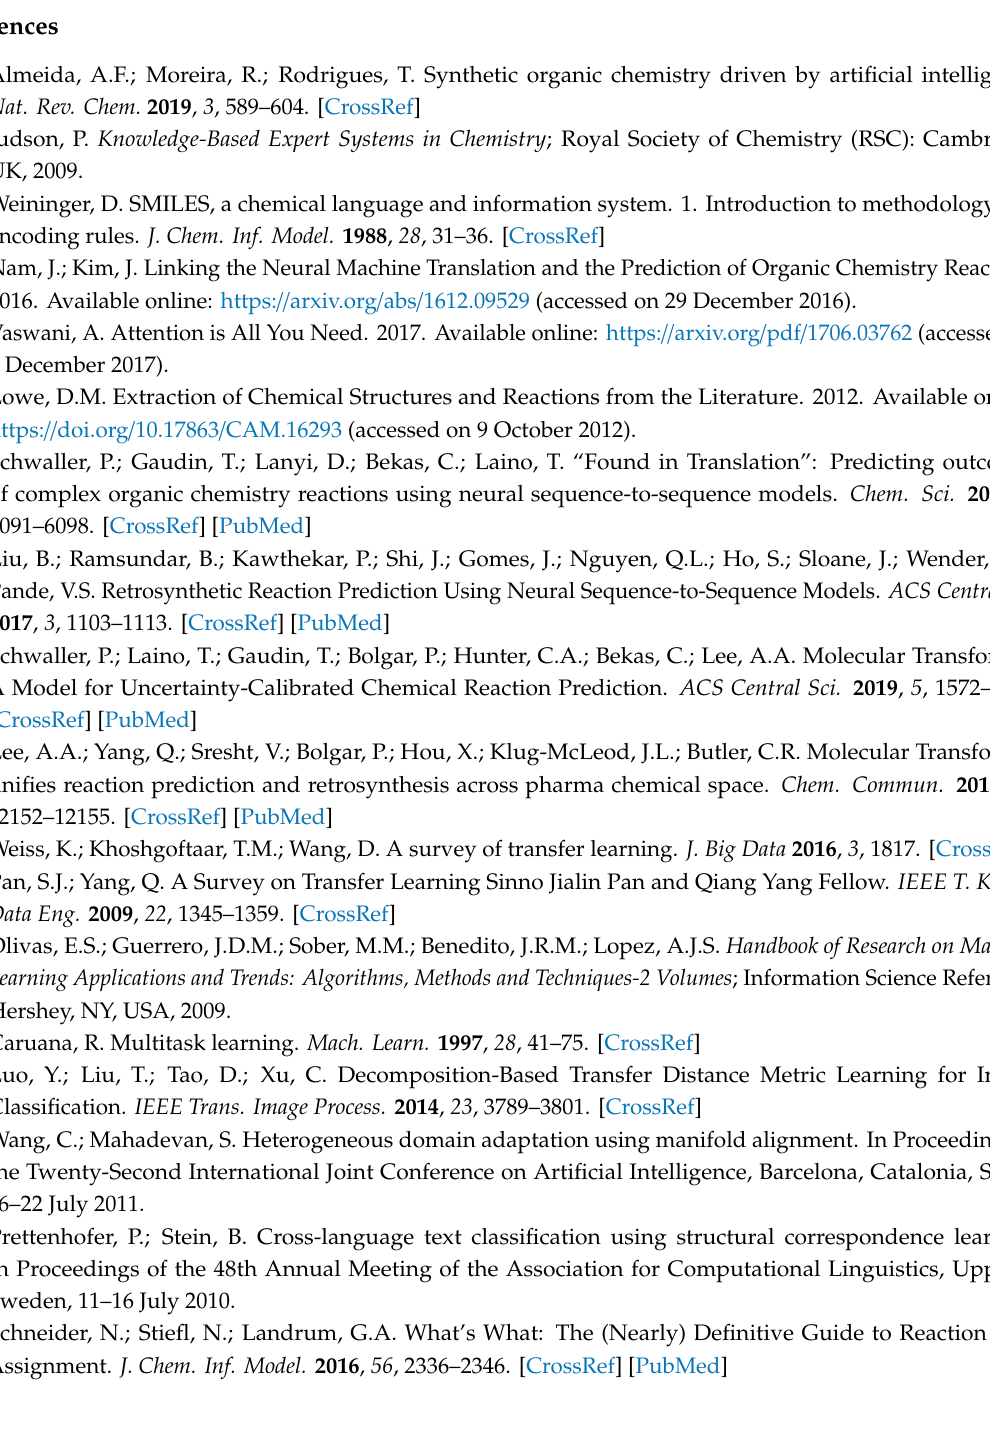
Supplementary Materials: Training, validation and test sets (SMILES structures of reactants and products including reaction class designation) used in modelling are